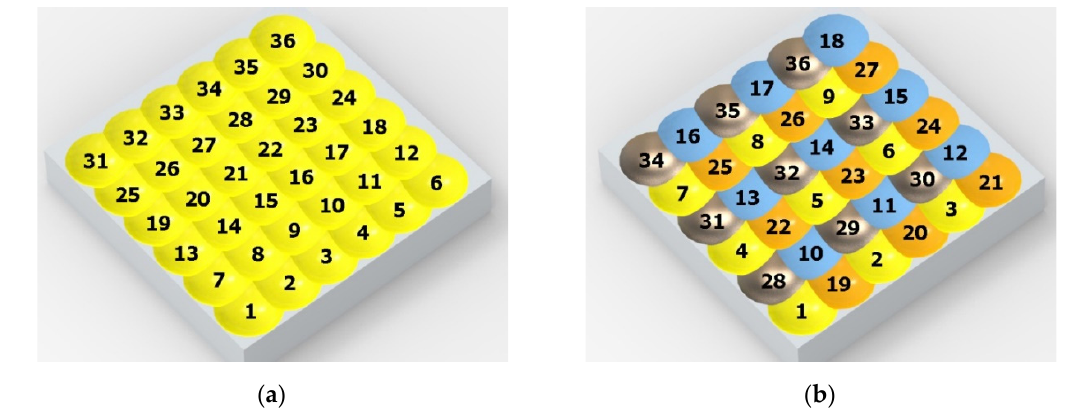
Figure 4. Comparison of the dimple formation methods: ( a ) RSP, ( b ) SRSP.